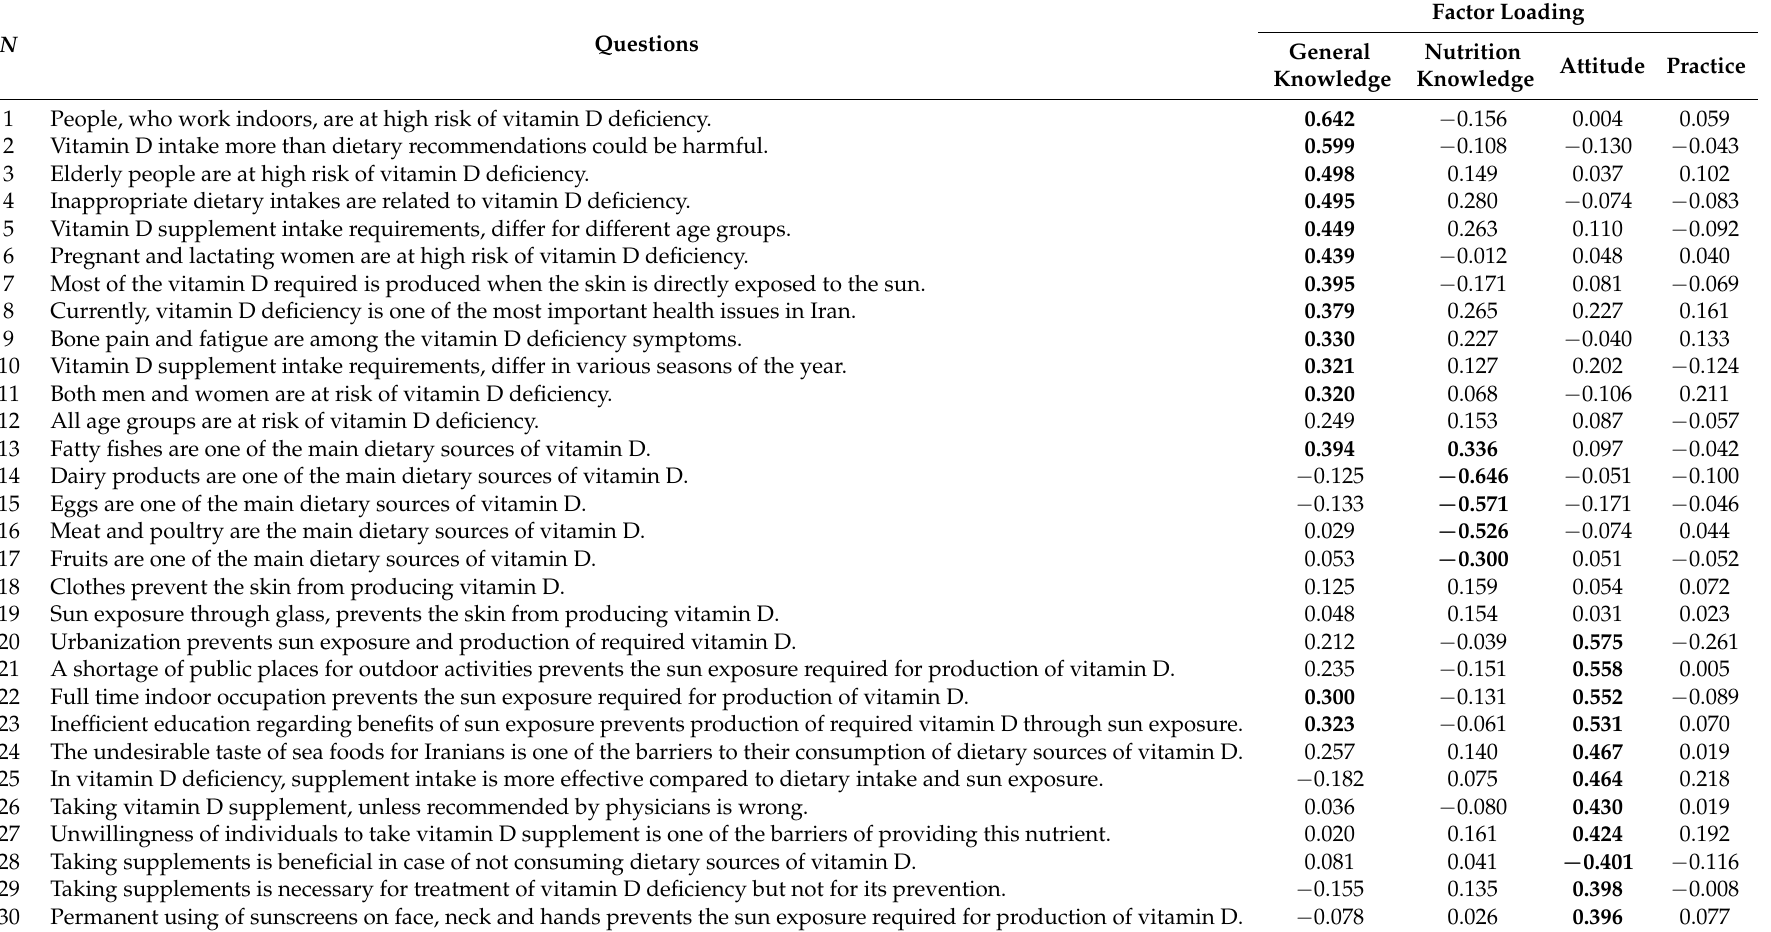
Table 2. Factor loading matrix of